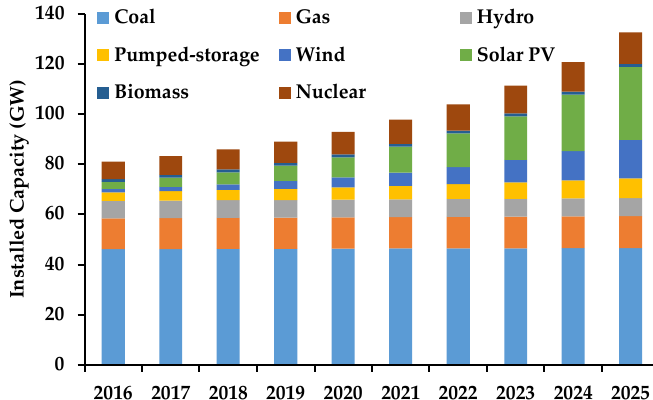
Energies 2018 , 11 , x FOR PEER REVIEW Figure 1. Installed capacities mix in the planning horizon. Figure 1. Installed capacities mix in the planning horizon.